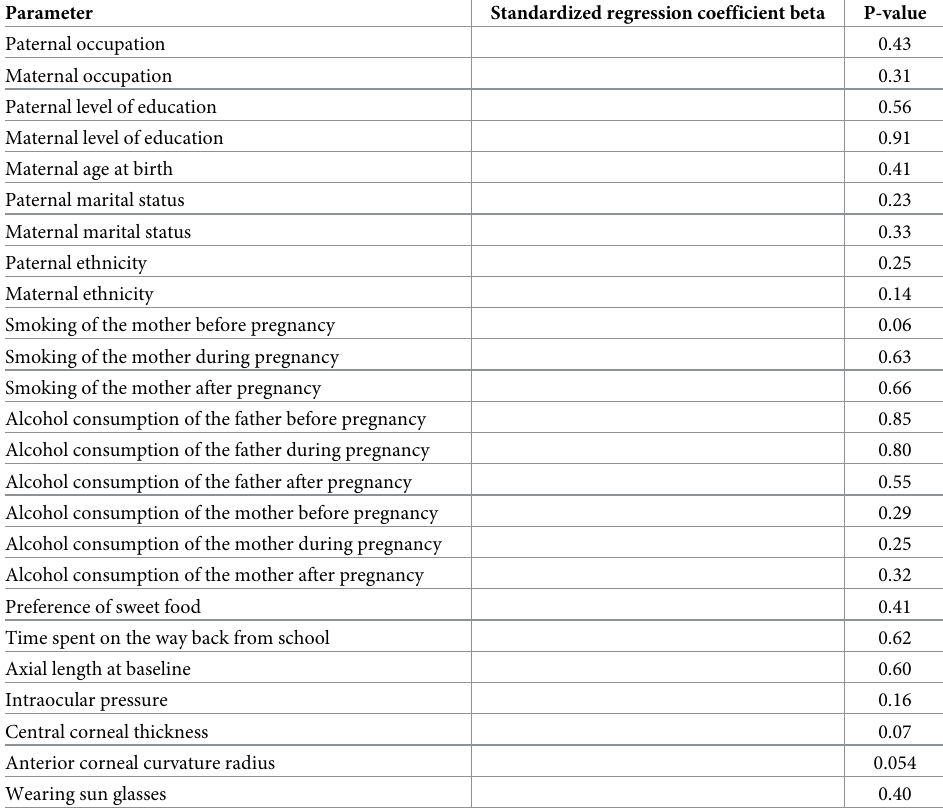
versus 0.22 mm, and 0.09 mm versus 0.14 mm, respectively) (Table 1). Correspondingly, in the children aged � 9 years at study end, the axial length at study end was larger by 0.20 mm